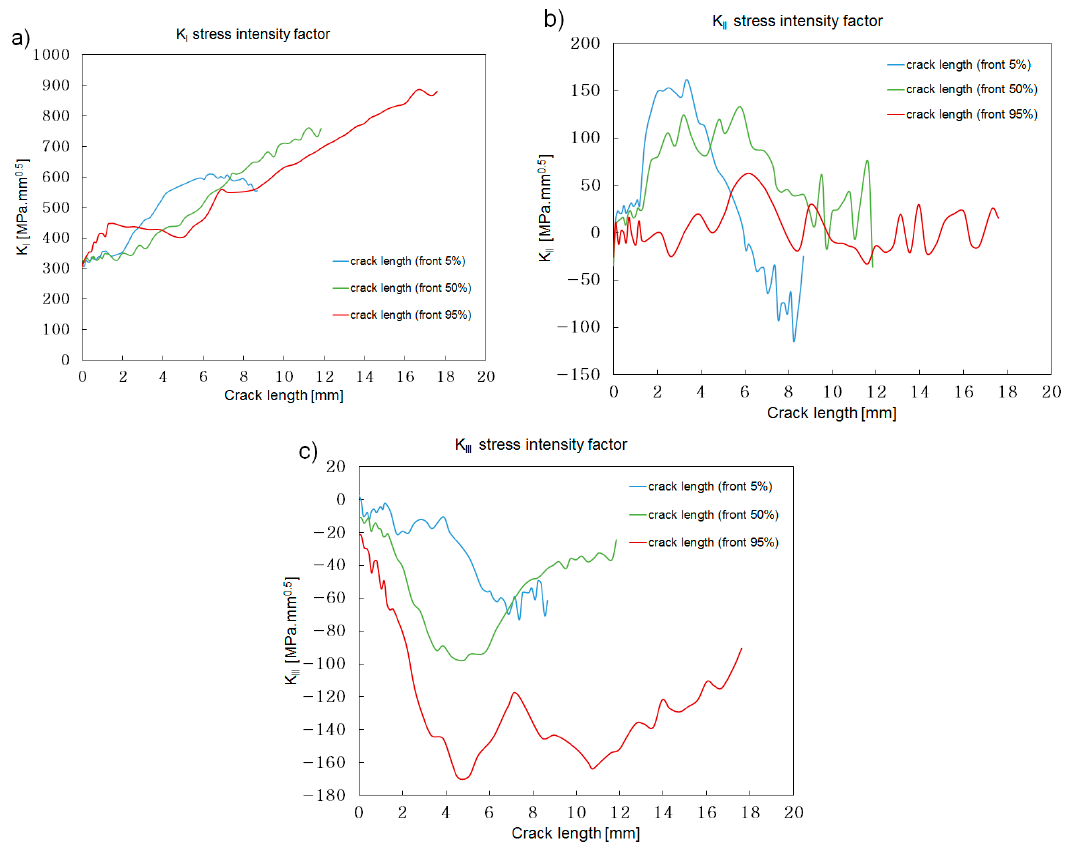
Figure 20. The 45° angle, short flank. Stress intensity along the three crack paths selected: ( a ) K I ; ( b ) K II ; ( c ) K III .